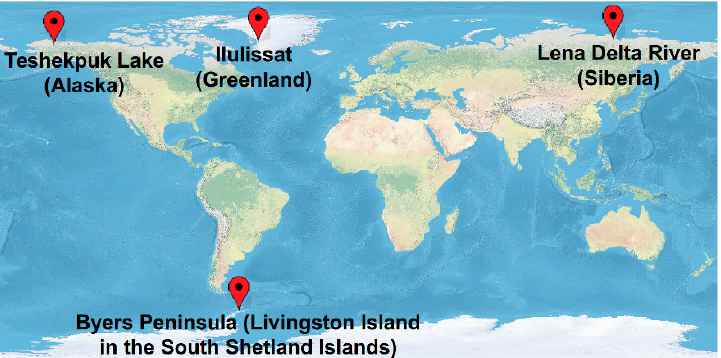
Figure 1. Study regions in the Arctic (from west to east Teshekpuk Lake in Alaska, Ilulissat in Greenland and the Lena River Delta in Siberia) and Antarctica (Byers Peninsula of Livingston Island in the South Shetland Islands).